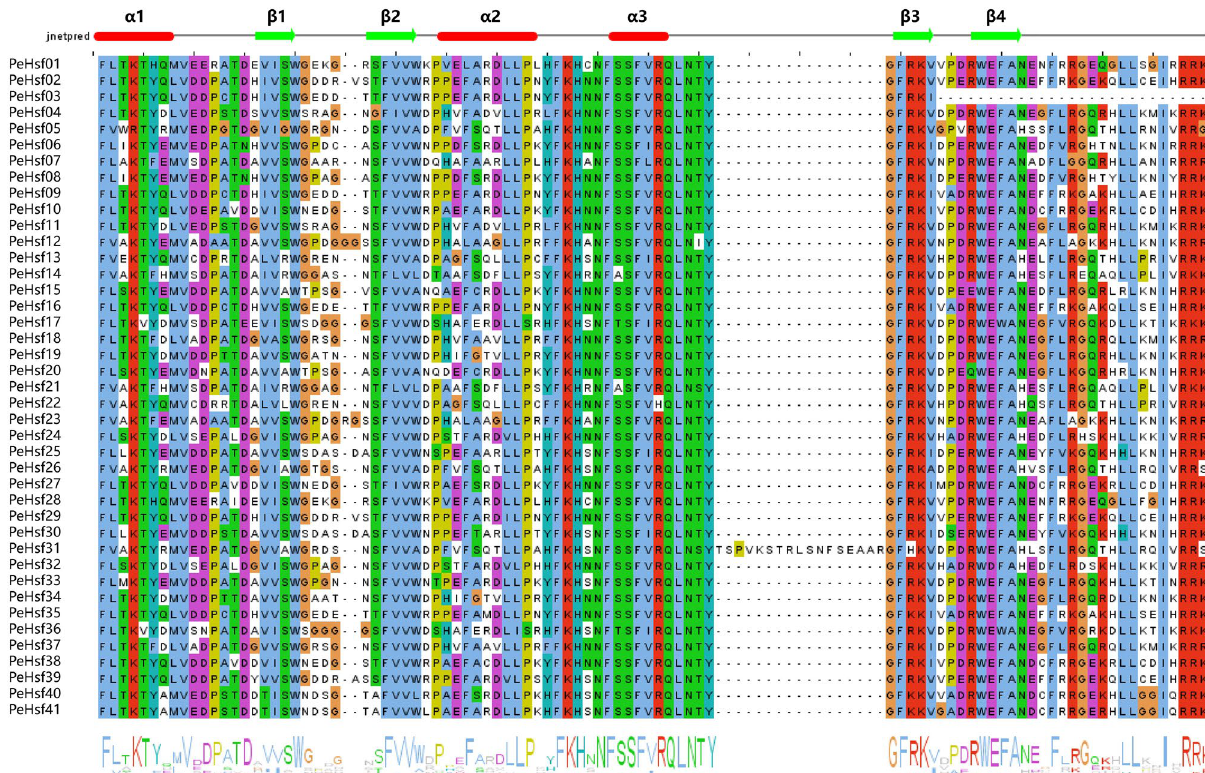
Figure 2. Multiple sequence alignment of the DNA-binding domains (DBDs) of HSF proteins from moso bamboo. Secondary structure elements of the DBDs (α1-β1-β2-α2-α3-β3-β4) based on JNet structure predictions are shown above the alignment (see Methods). α-helices are indicated by red bars, and β-folds are indicated by green arrows. The amino acid sequences of conserved domains were compared and edited using Jalview software (V2.10.5) (http:// www. jalvi ew. org/) 2 , and the Jalview output was submitted to JPred (http:// www. compb io. dundee. ac. uk/ jabaws) for protein secondary structure prediction using default parameters(Supplementary Table S2)